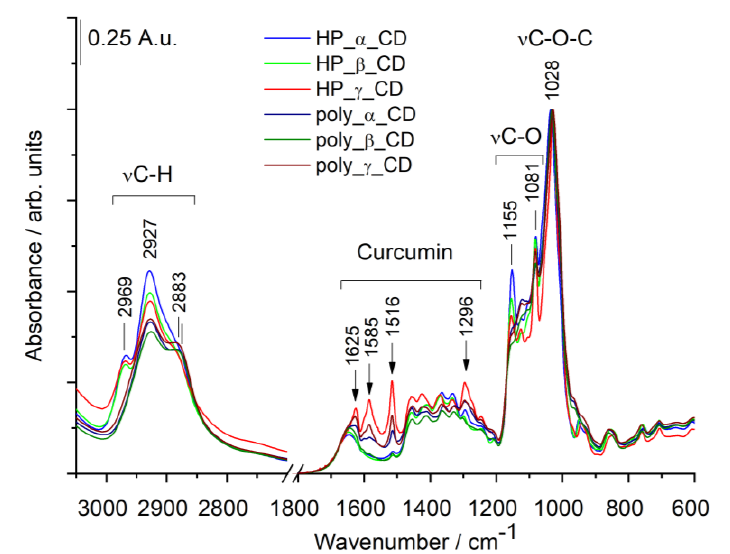
Figure 5. Infrared(IR)spectra of curcumin loaded CD samples. Spectra are normalized to the C-O-C stretching band around 1028 cm −